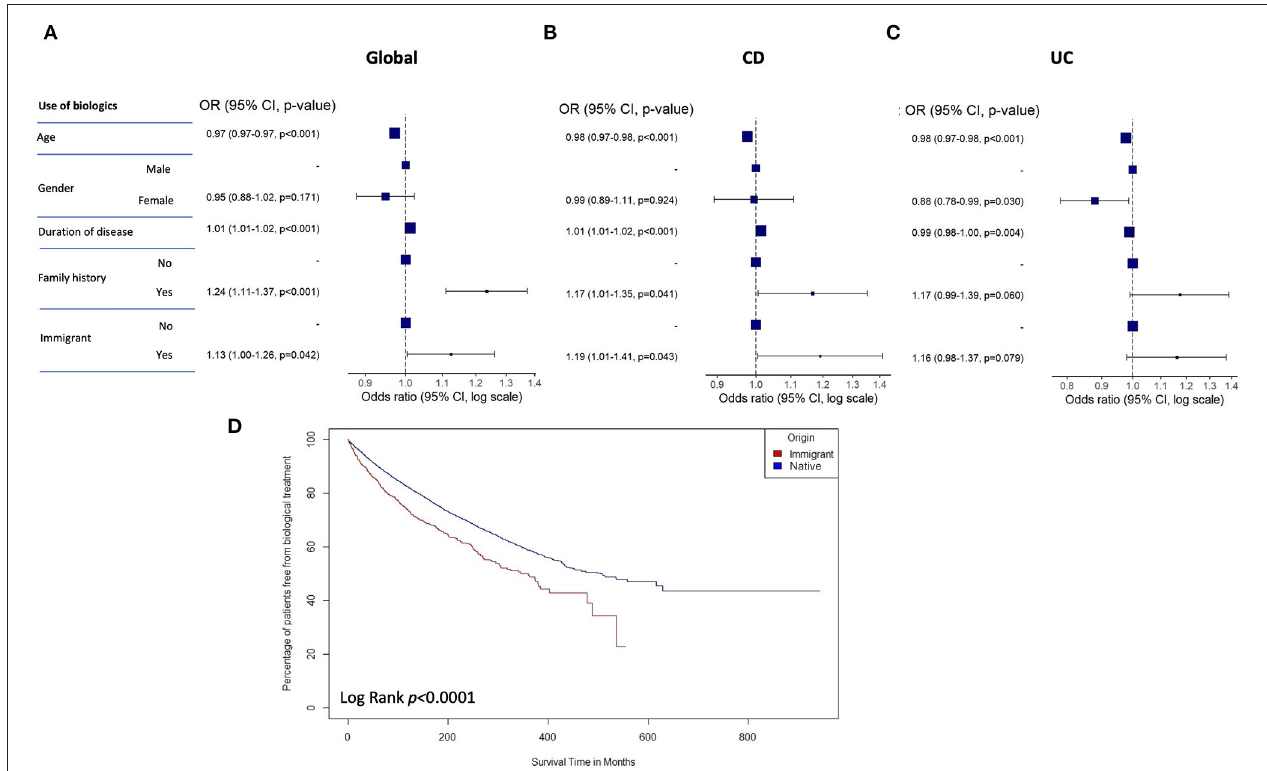
FIGURE 3 | Forest plots representing the odds ratio for using biologics in the multivariate analysis for the global (A) , CD (B) , and UC (C) cohorts of patients. (D) Survival analysis of the time to first biologic drug in immigrant vs. native patients. CD, Crohn’s disease; UC, ulcerative